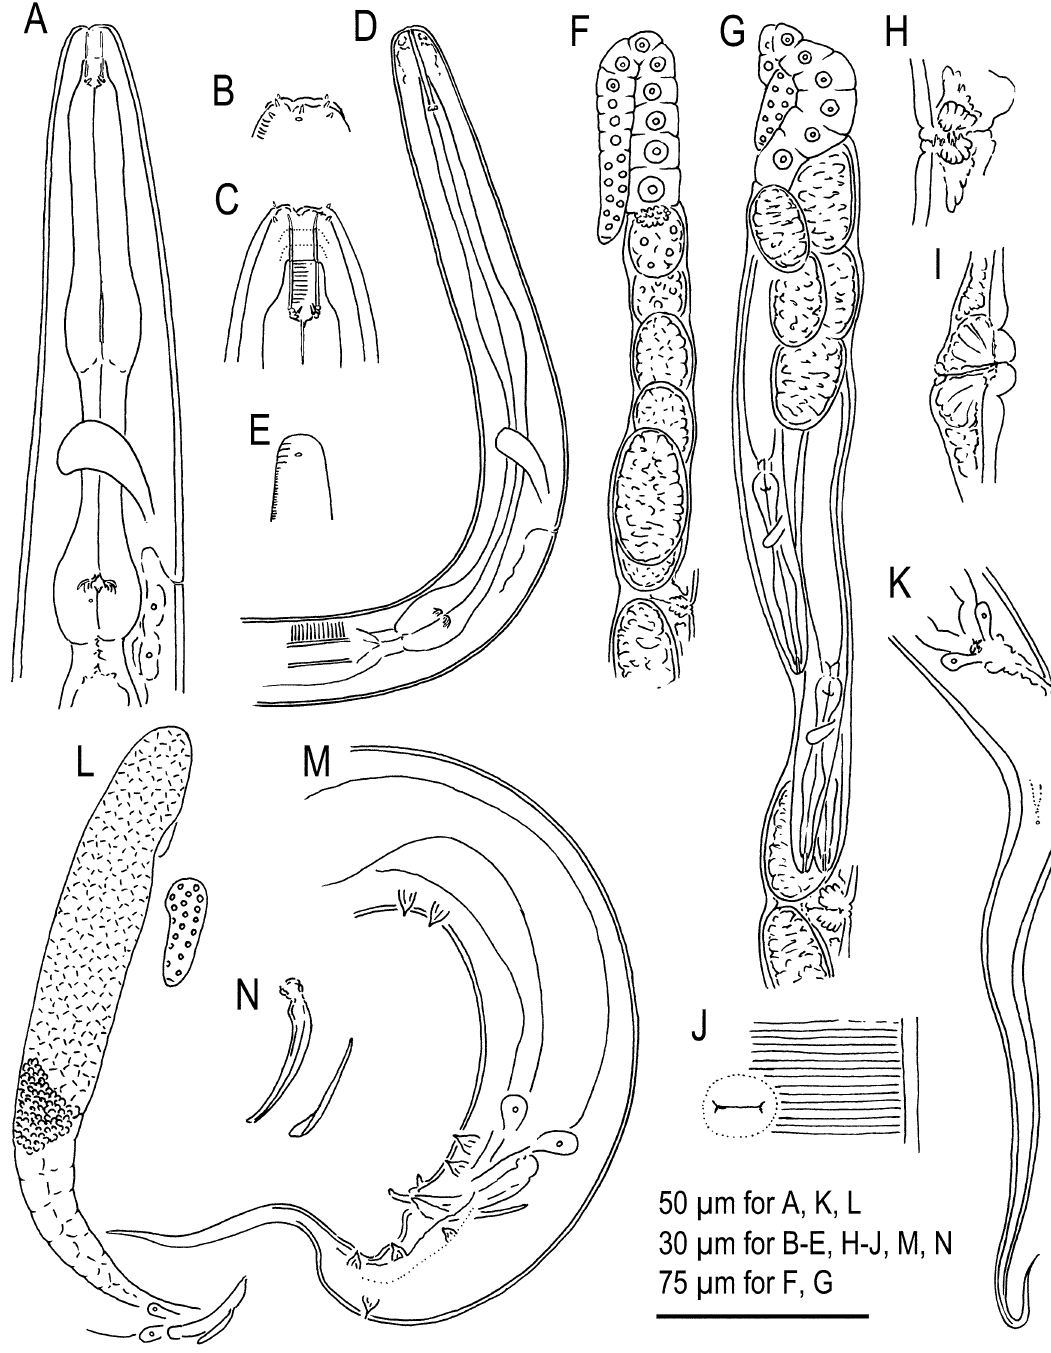
Figure 2. Hermaphrodite, male and dauer juvenile of Tokorhabditis tufae n. gen., n. sp. ( A ) Anterior part of hermaphrodite in right lateral view; ( B ) Surface of lip region of hermaphrodite; ( C ) Stomatal region of hermaphrodite in right lateral view; ( D ) Anterior part of dauer juvenile in right lateral view; ( E ) Surface of lip region of dauer juvenile; ( F ) Anterior gonad of young hermaphrodite in right lateral view; ( G ) Anterior gonad of mature hermaphrodite in right lateral view; ( H ) Vulval region of young hermaphrodite in left lateral view; ( I ) Vulval region of mature hermaphrodite in right lateral view; ( J ) Ventral view of young hermaphrodite in ventral view; ( K ) Tail region of hermaphrodite in right lateral view; ( L ) Male gonad in right lateral view where reflex part is drawn separately; ( M ) Male tail region in left lateral view; ( N ) Spicule and gubernaculum in left lateral